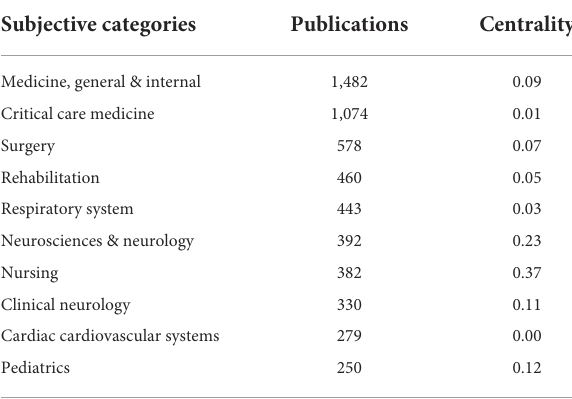
TABLE 1 Top-ten subjective categories with